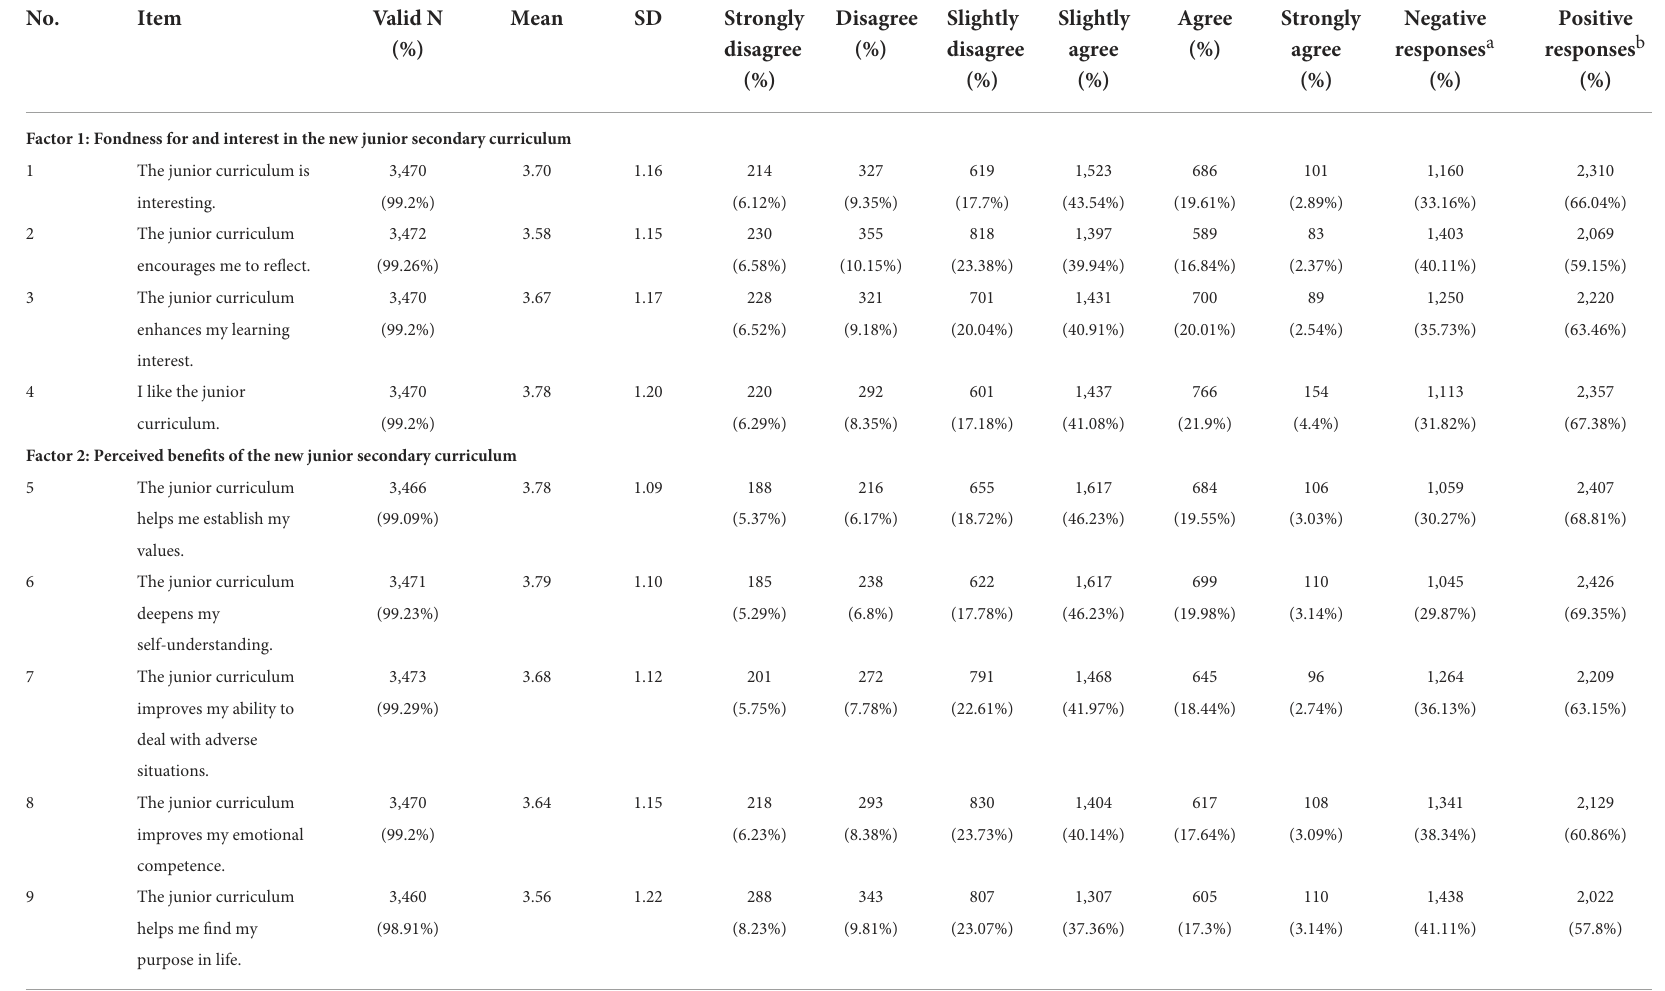
TABLE 4 Percentages of responses to the questions on academic satisfaction with the junior curriculum.